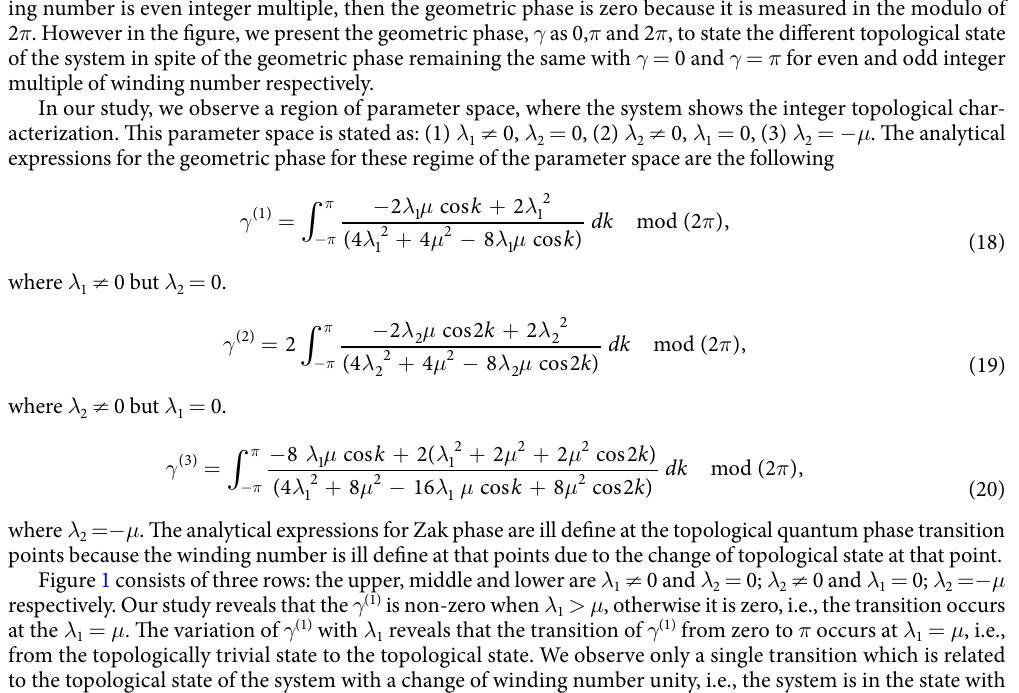
integer topological characterization. Therefore, in this regime of parameter space the topological characterization of the state is the same both for Zak phase and winding number study. Only at the topological quantum phase